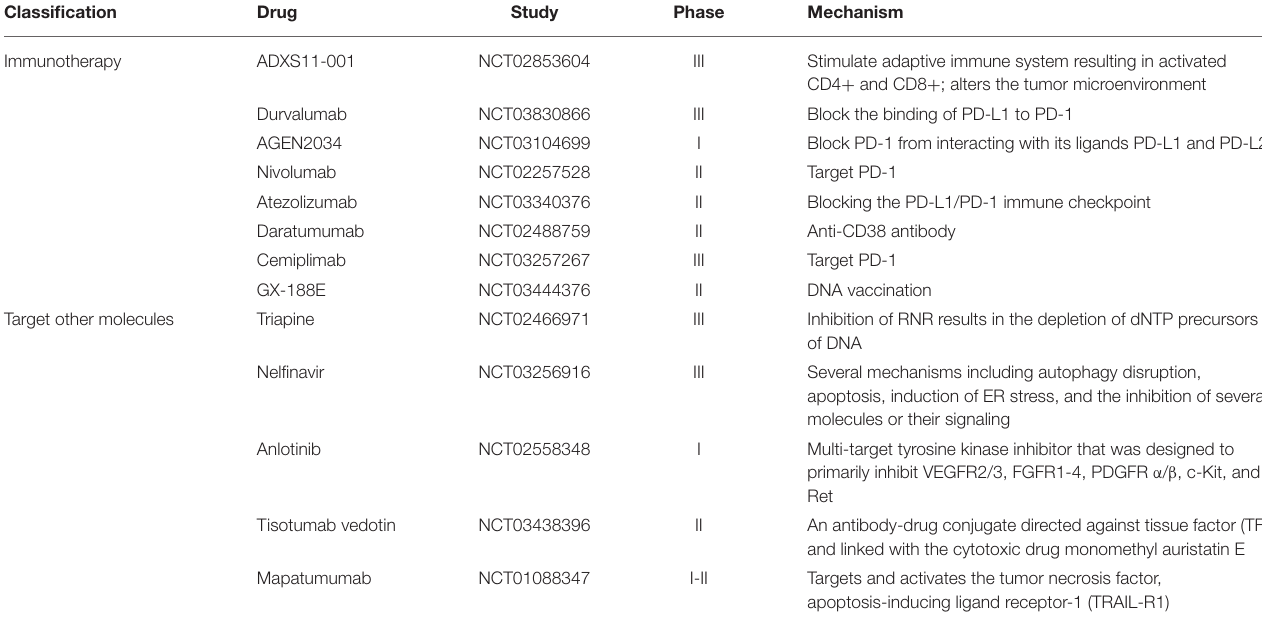
TABLE 2 | Emerging drugs ongoing clinical trials for cervical cancer treatment.